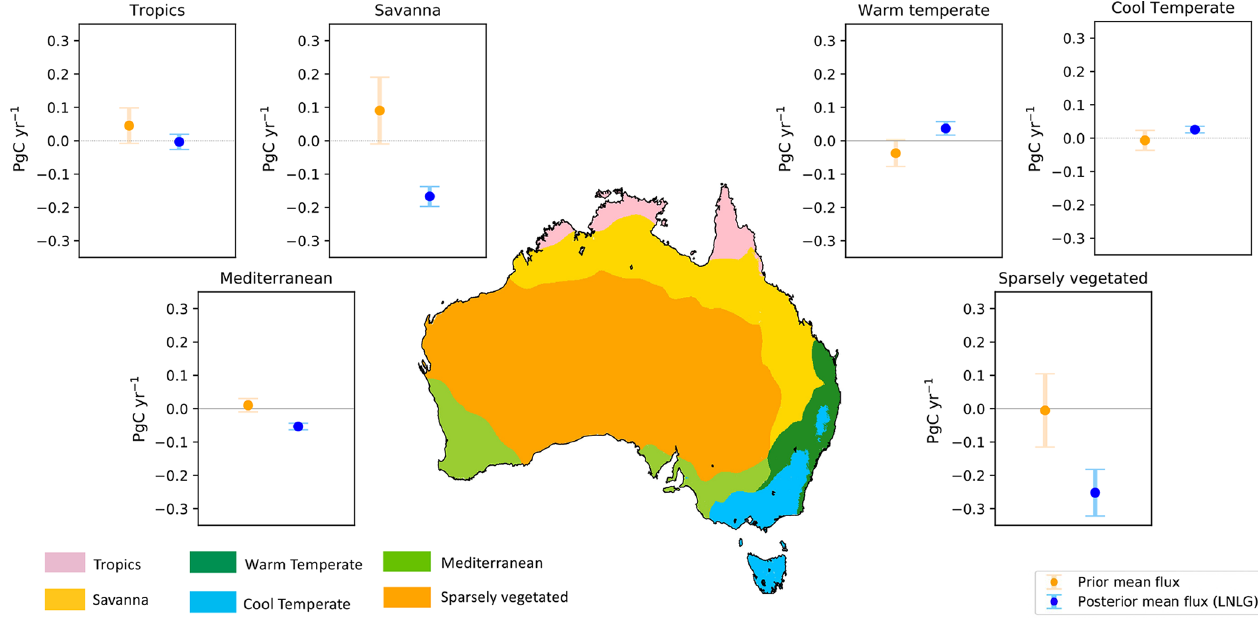
Figure 8. Annual prior and posterior flux estimates aggregated into six bioclimatic classes (tropics, savanna, warm temperate, cool temperate, Mediterranean and sparsely vegetated) over the Australian region. Fossil fuel emissions are